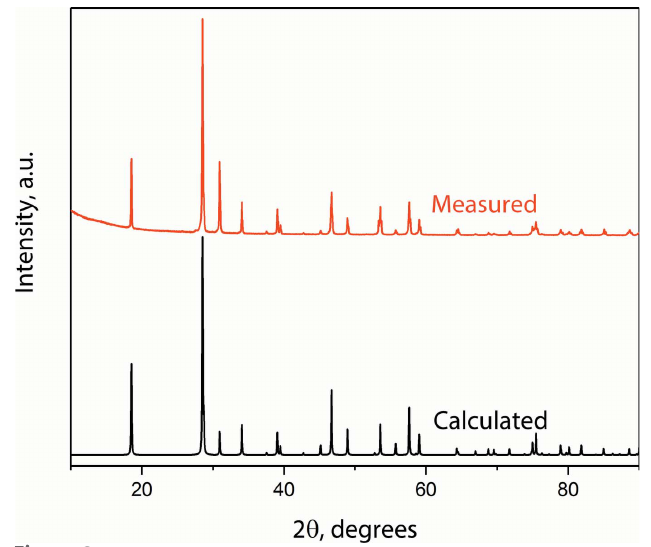
Figure 3 Comparison between P-XRD pattern of ground Ca 0.84 Sr 0.16 MoO 4 single crystals and calculated pattern generated from the solved structure.